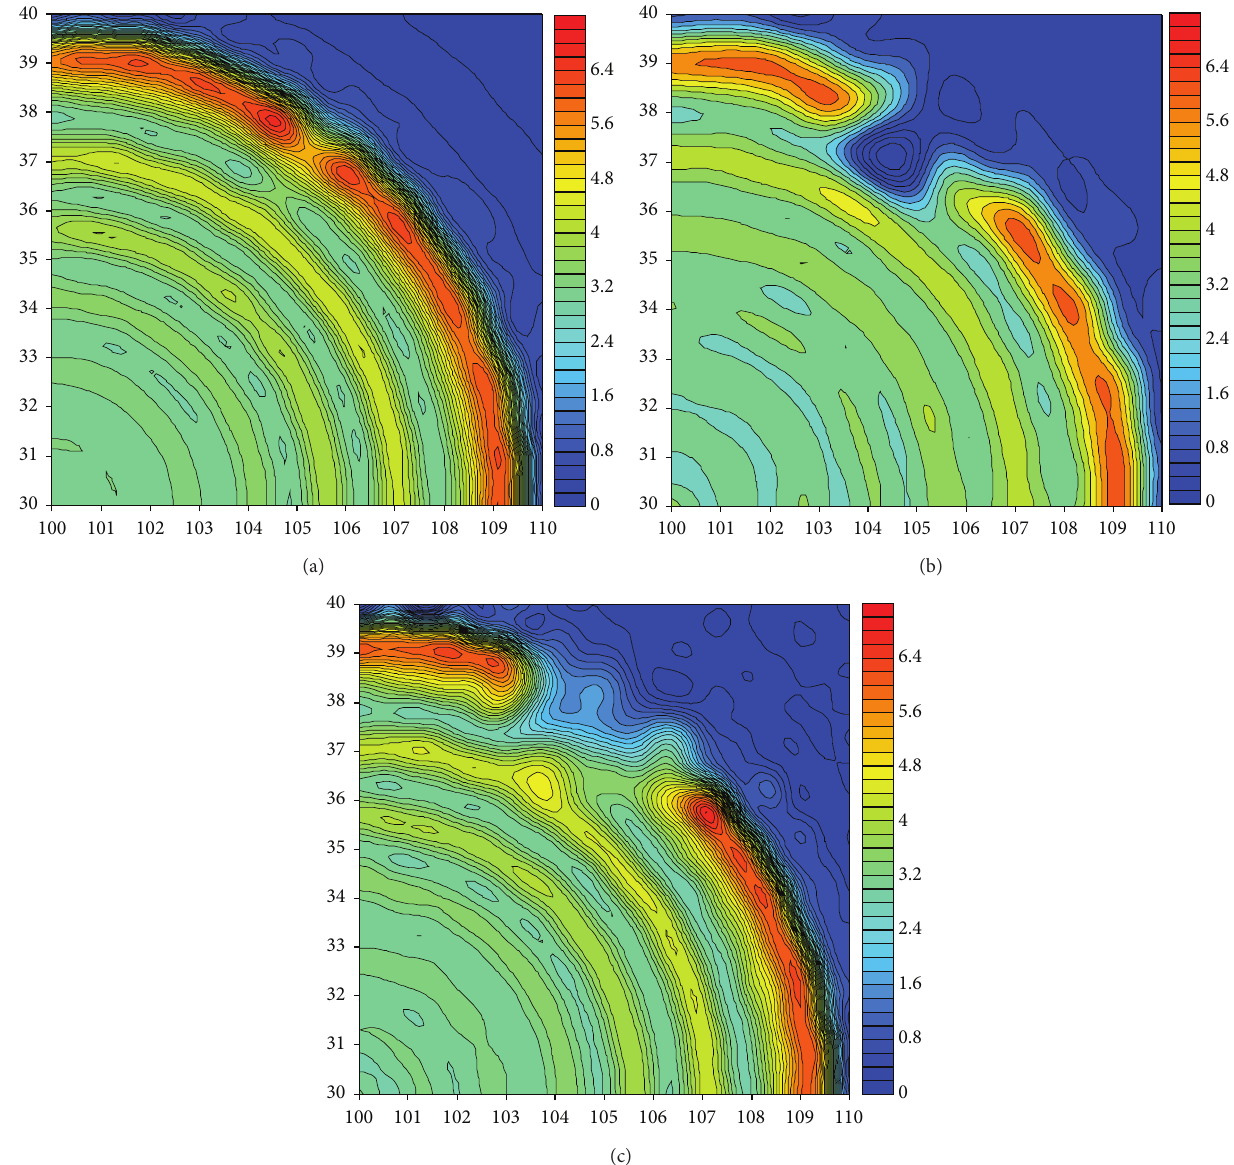
Figure 5: The analyzed temperature fields (unit: ∘ C) using (a) GDF, (b) DF with 𝑎, 𝑏 = 0.8 , (c) DF with 𝑎, 𝑏 = 0.5 .